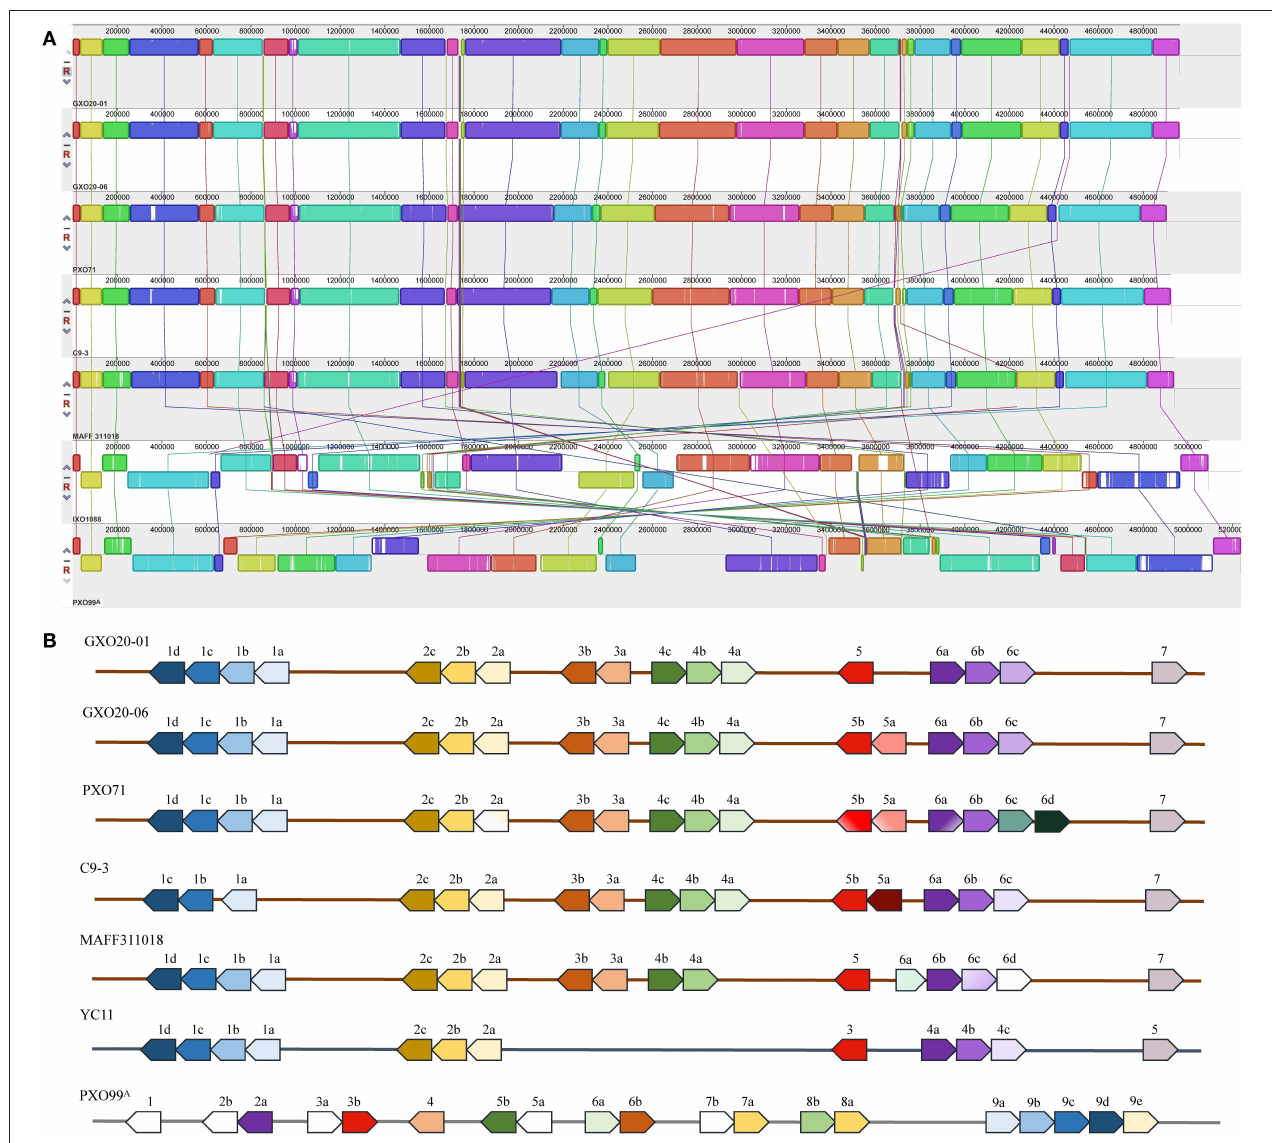
FIGURE 2 | Comparison of whole genomes and tal genes of Xoo strains. (A) Progressive Mauve alignments chromosomes of Xoo strains. Colinear blocks are shown in green, with gray indicating regions of sequence dissimilarity. The ruler indicates distance from the annotated origin in base pairs. (B) The tal genes of Xoo strains. The genes are represented as arrows at their relative positions in the linearized chromosome. Arabic numerals indicate the serial number of tal gene clusters in an Xoo strain, and each lowercase letter indicates each tal gene in a certain gene